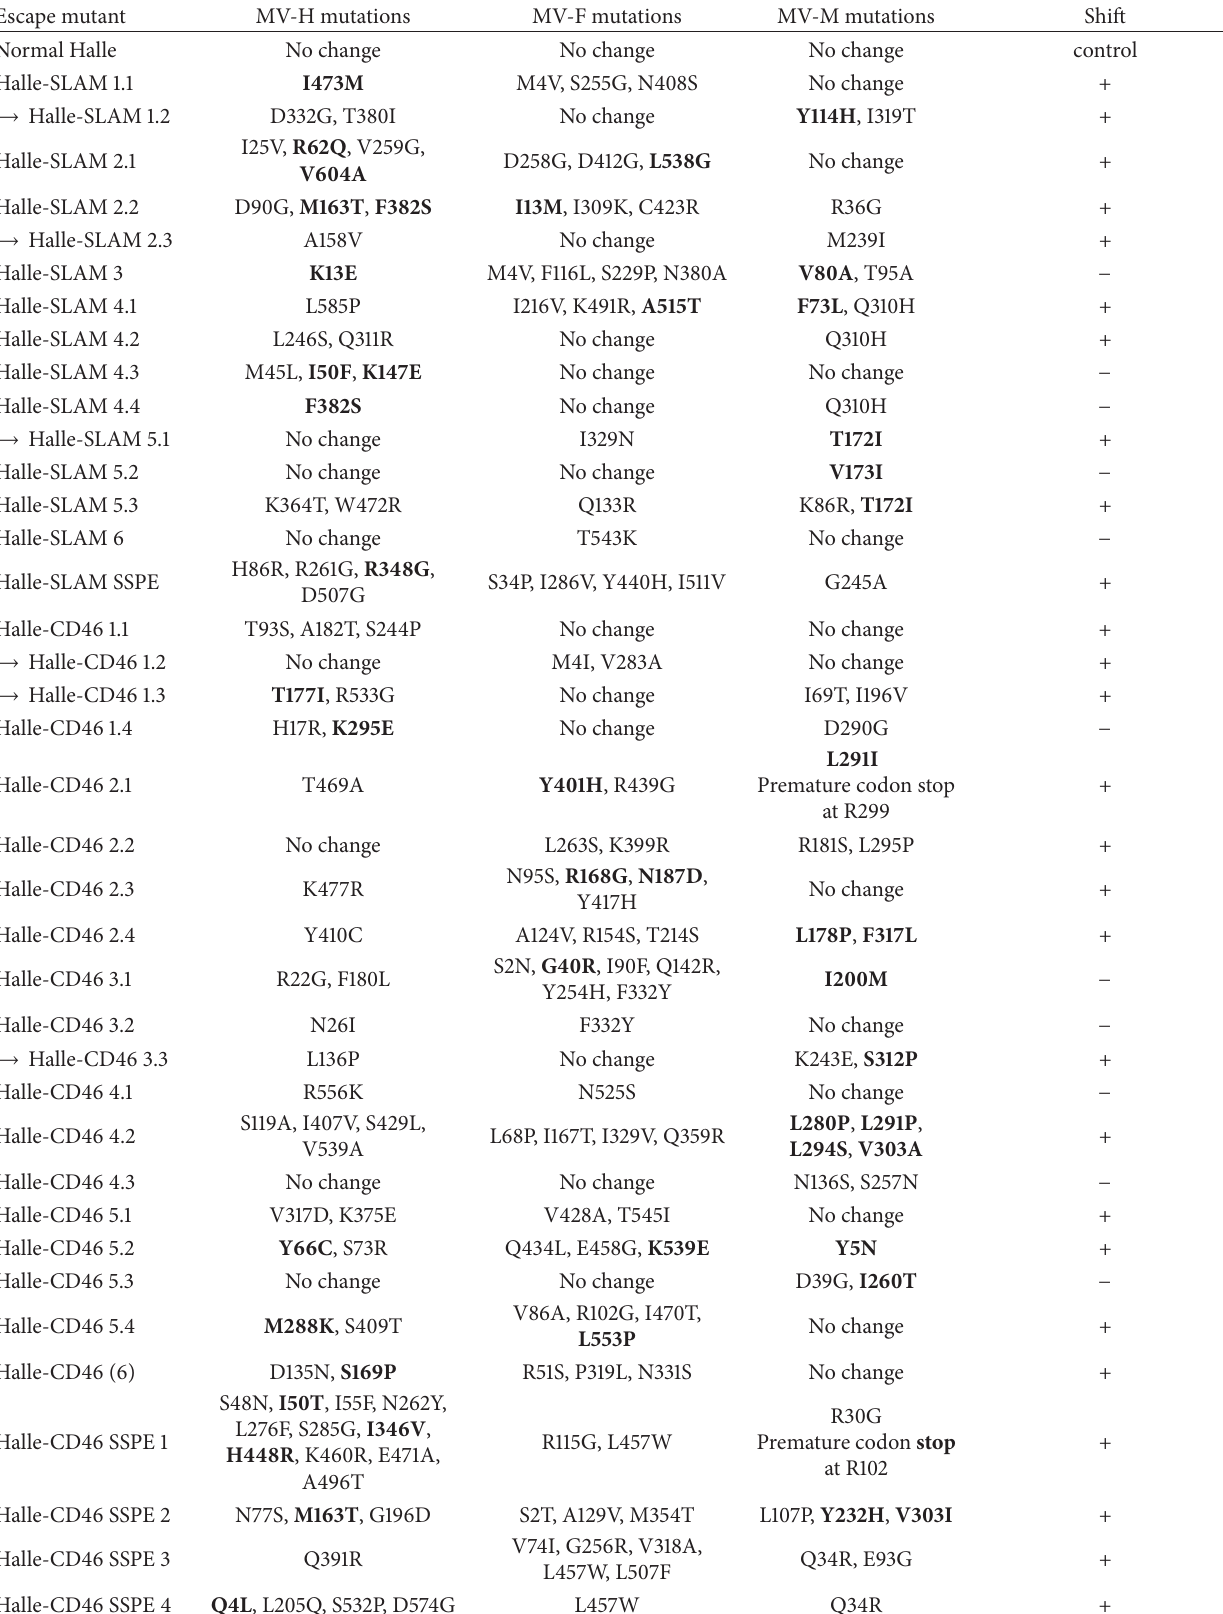
Table 2: Mutations present in the H, F, and M genes of MV-Halle escape mutants obtained by in vitro immune selection. Escape mutant MV-H mutations MV-F mutations MV-M mutations